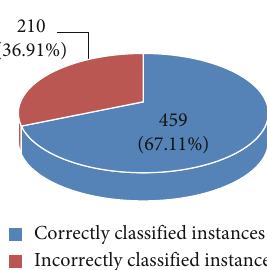
Figure 14: Success percentages of the hierarchical clustering